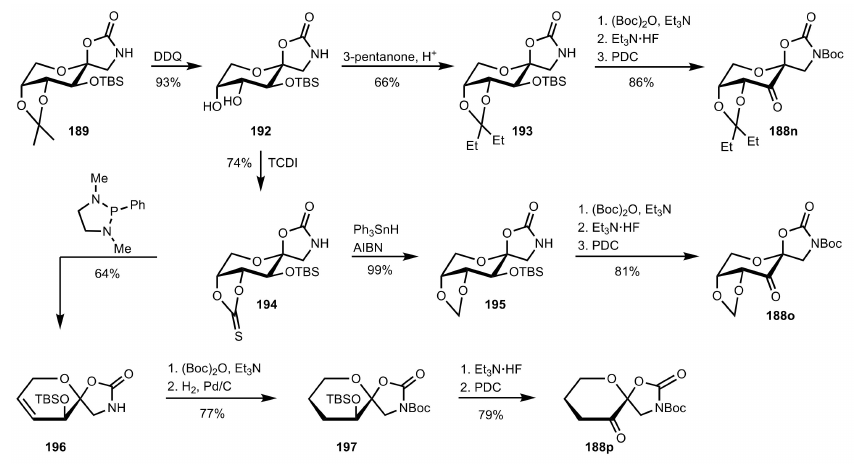
Scheme 45. The synthesis of sugar ketone organocatalysts 188n-p